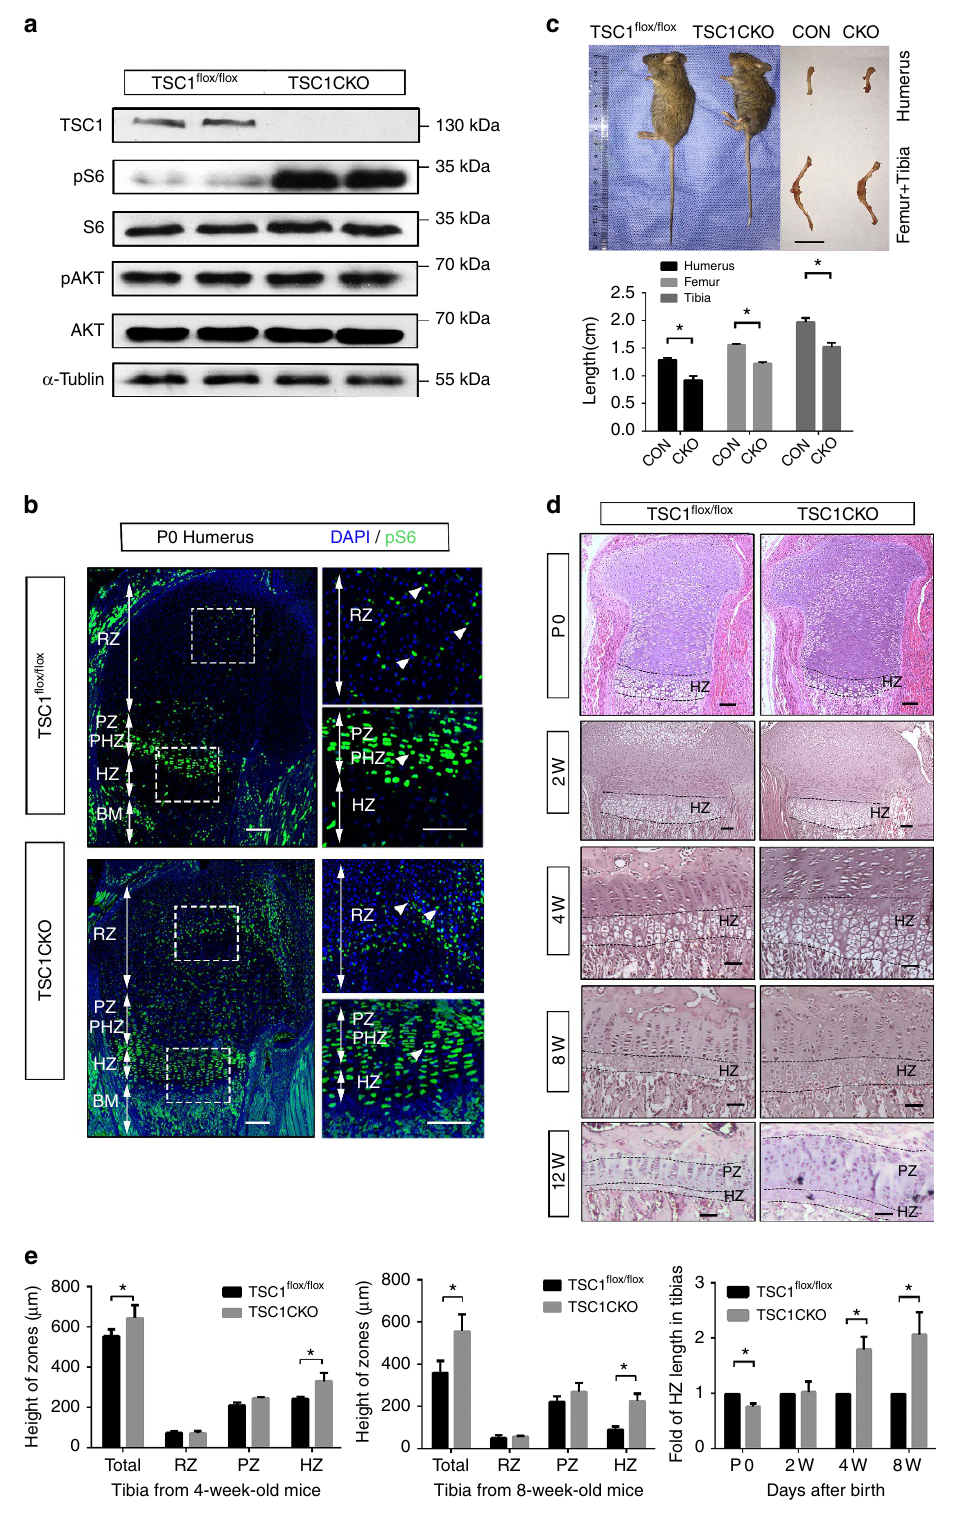
HZ Tibia from 4-week-old mice Figure 3 | Activation of mTORC1 in chondrocytes causes chondrodysplasia and dwarfness in mice. ( a ) Western blot of pure cartilage tissues harvested from rib or long bone of P0 TSC1 flox/flox and TSC1CKO mice. ( b ) pS6 immunofluorescence analysis of longitudinal frozen sections of control and TSC1CKO mouse humerus at P0. Boxed areas are represented by higher magnification below. White triangles show the pS6 positive chondrocytes. Scale bar, 200 m m. ( c ) Image of 8-week-old TSC1CKO mice and humerus, femur and tibia. Scale bar, 1cm. Student’s t -test, * P o 0.05, n ¼ 5; Error bars indicate s.d. ( d ) HE staining of tibia from 0-, 2-, 4-, 8- and 12-week-old mice. Upper lines specify where hypertrophic differentiation begins and lower lines show cartilage bone junctions. Scale bar, 100 m m. ( e ) Quantification of RZ, PZ and HZ lengths in 4- and 8-week-old TSC1CKO mice. Quantification of HZ length in tibia from 2-, 4- and 8-week-old mice. Student’s t -test, * P o 0.05, n Z 3; Error bars indicate s.d.